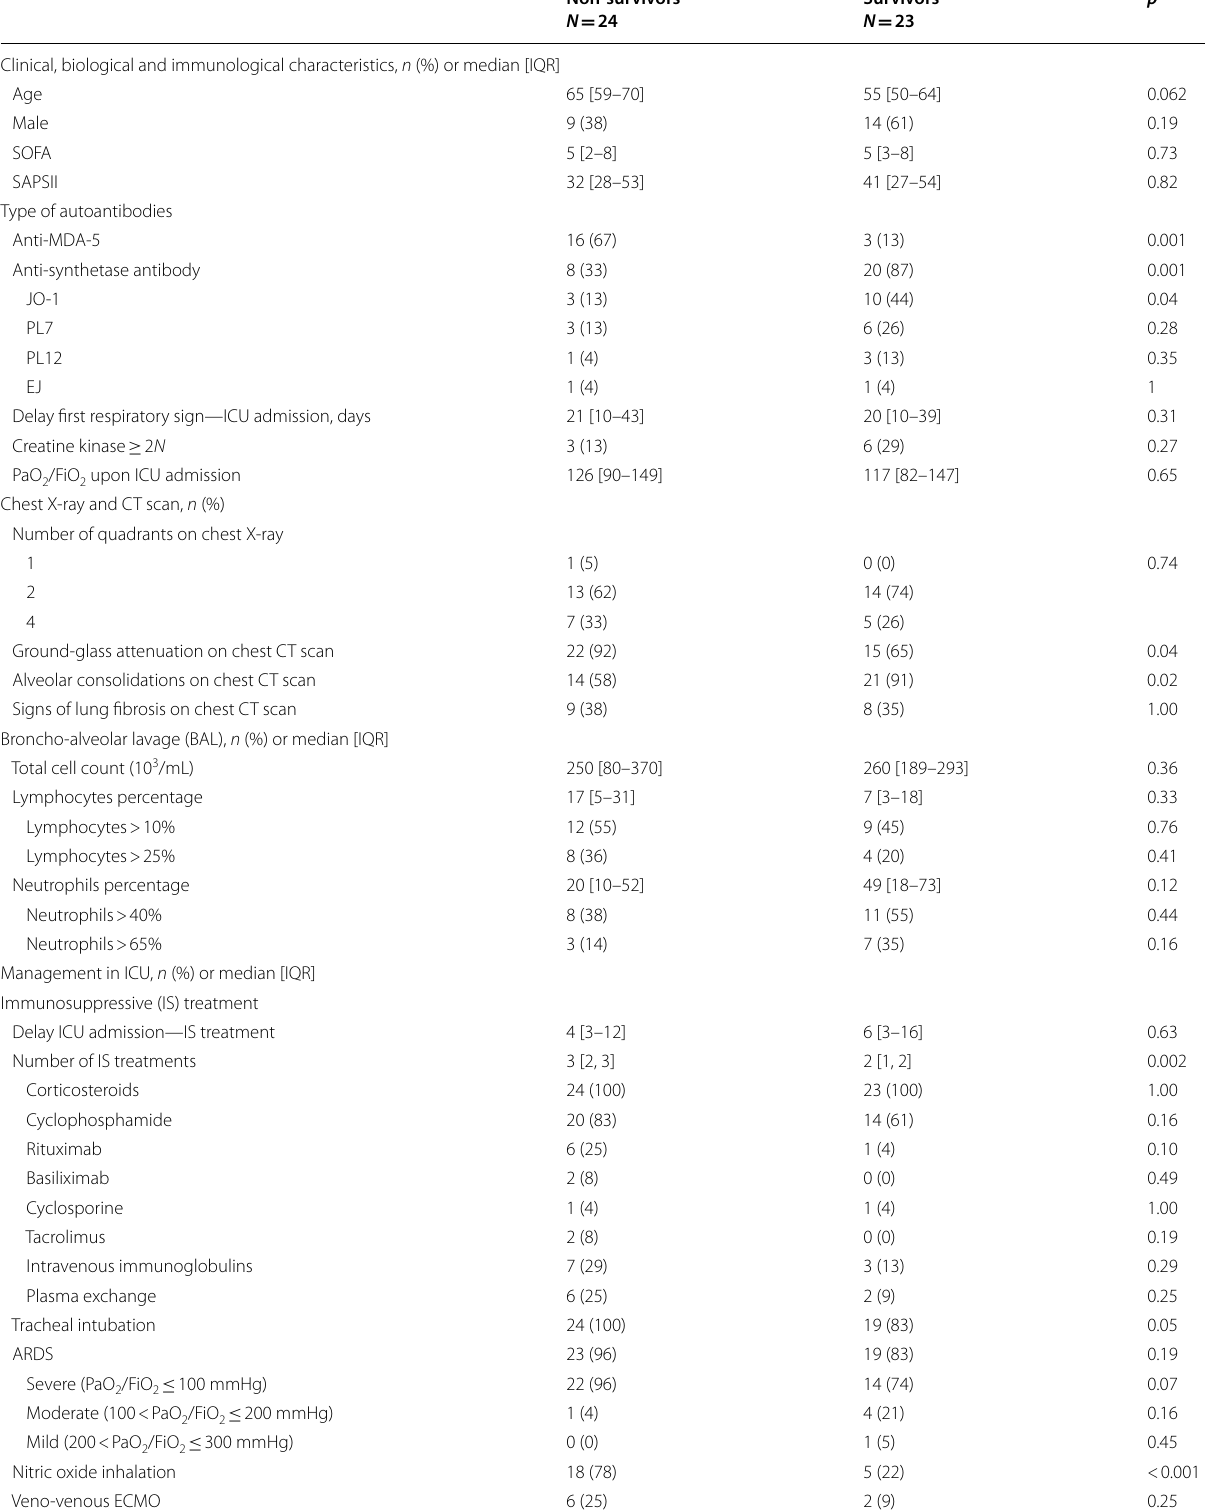
Table 4 Comparison between hospital survivors and